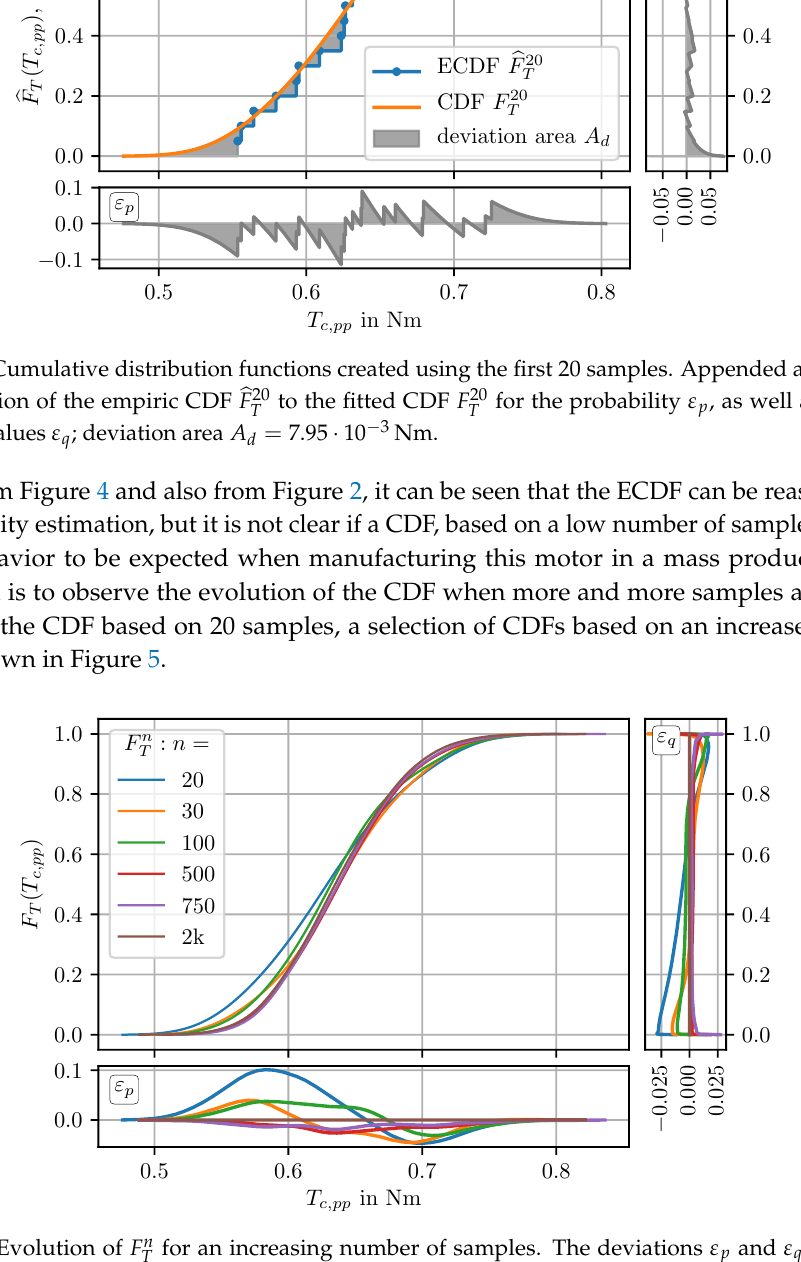
Figure 5. Evolution of F n for an increasing number of samples. The deviations ε p and ε q are with T respect to the reference CDF F 2 k T